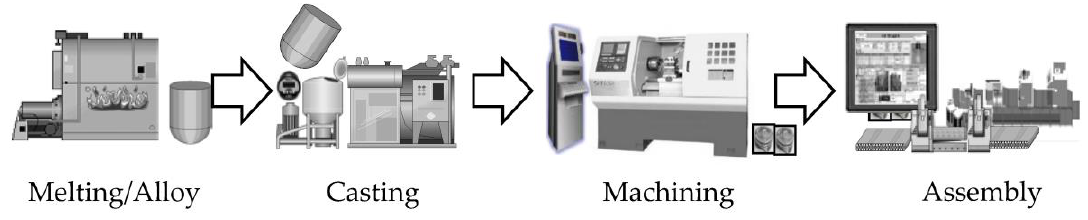
Figure 2. Overall process of the casting factory.